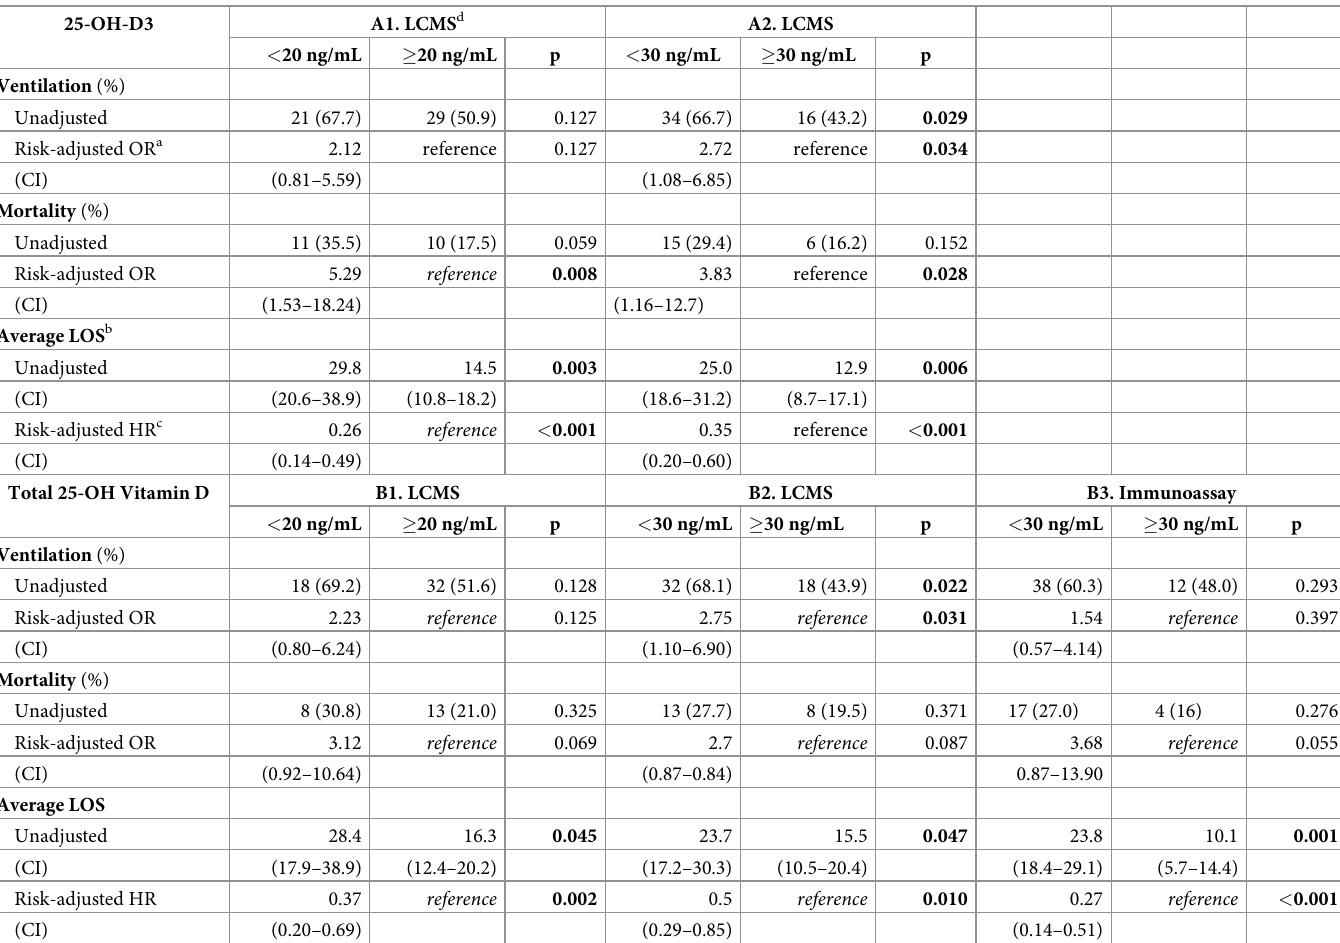
Table 3 focuses on COVID-19 positive patients deficient of 25-OH-D3 by LCMS, and defi- cient and insufficient of tD by LCMS and immunoassay. The deficient and insufficient cutoffs were used according to universal consensus accepted by US Endocrine Society for normal Table 3. Analyses of the cutoff levels versus ventilation, mortality, and hospital